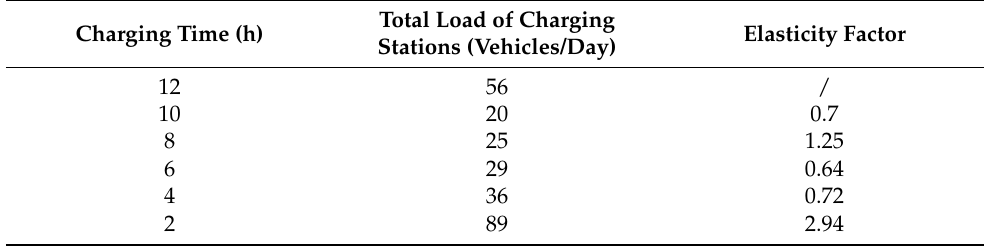
Table 3. Example parameter values.